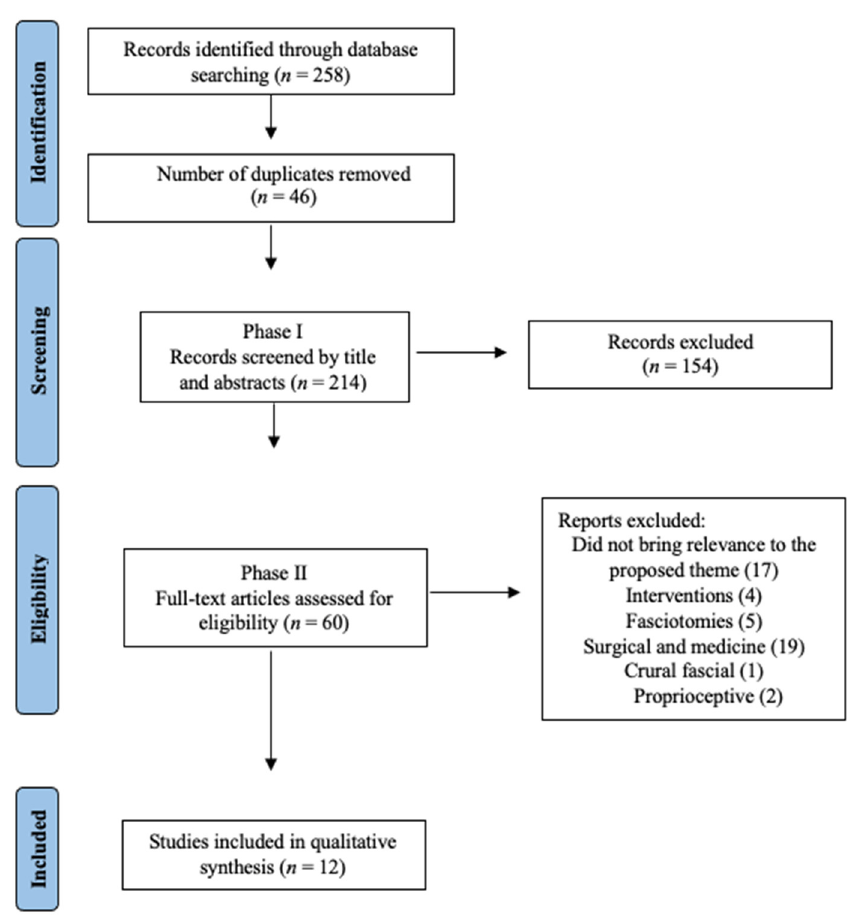
Figure 1. Flowchart diagram (file in attachment).